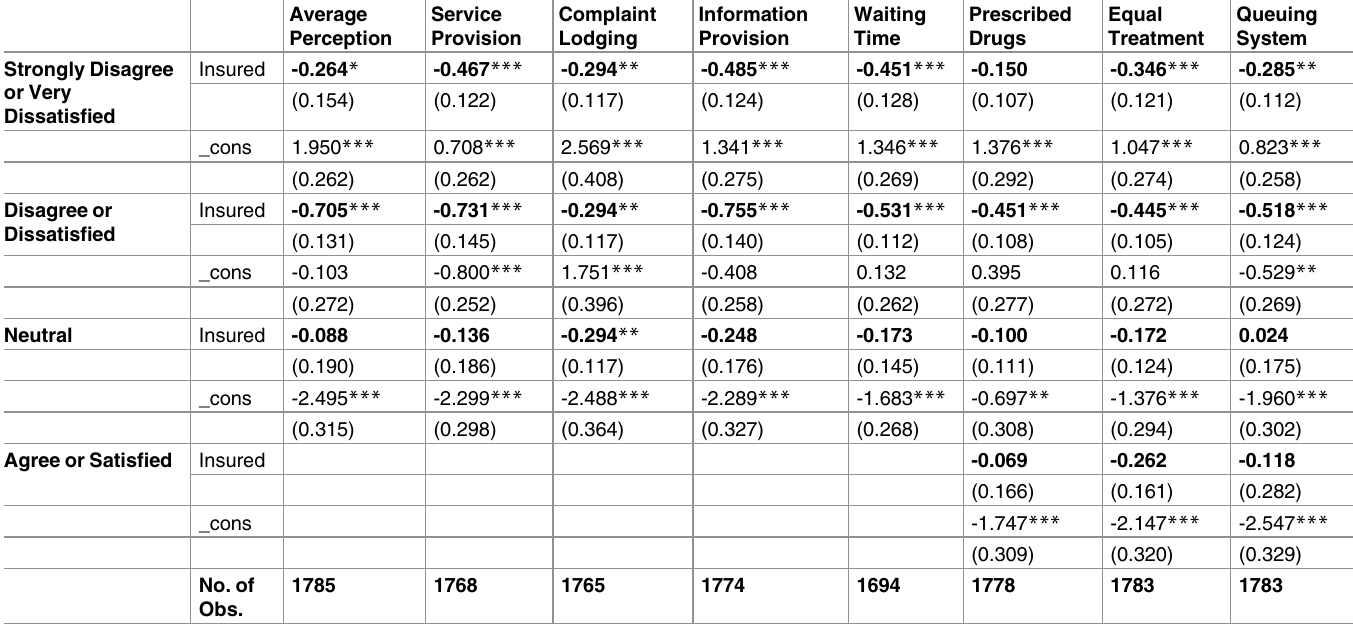
Table 3. Effect of currently insured status on perceived quality of